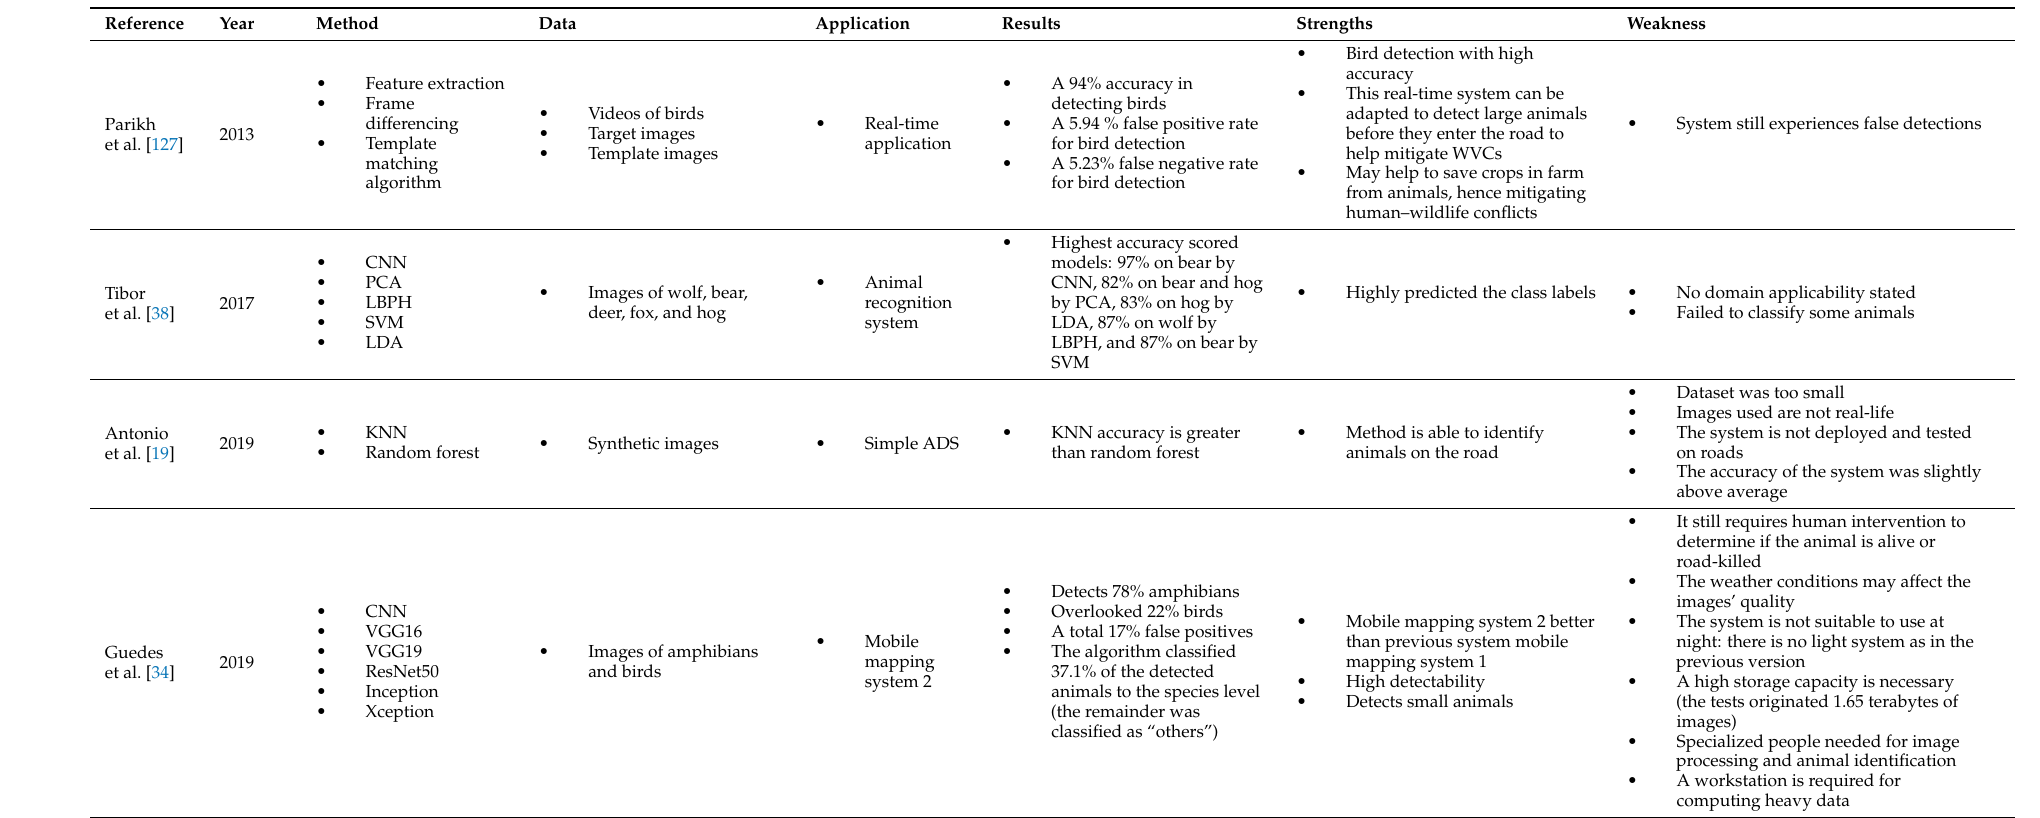
Table 10. Comparison of machine learning methods used to mitigate